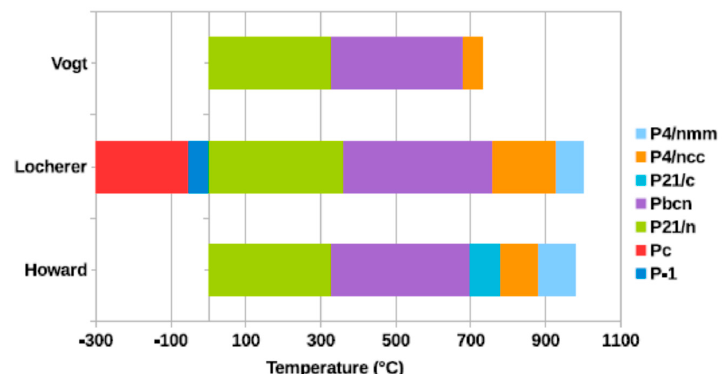
Figure 1. A visual summary of the crystallographic phase transitions in WO 3 , as obtained from